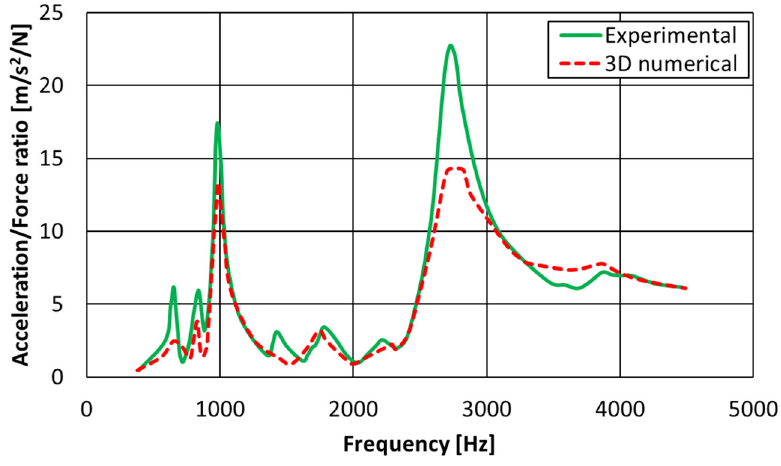
Figure 4. Experimental and numerical (“full 3D”) inertance vs. frequency measured at engine bracket, with excitation in the same point (highlighted in Figure 3a).